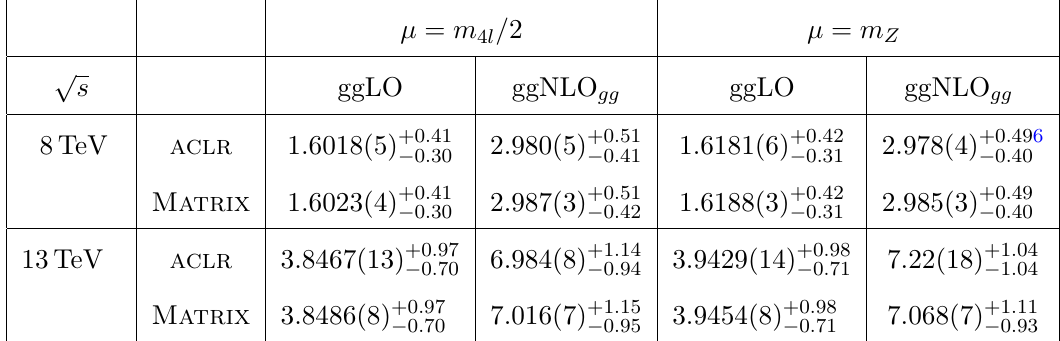
Table 1 . Comparison of our Matrix results with those of ref. [35].